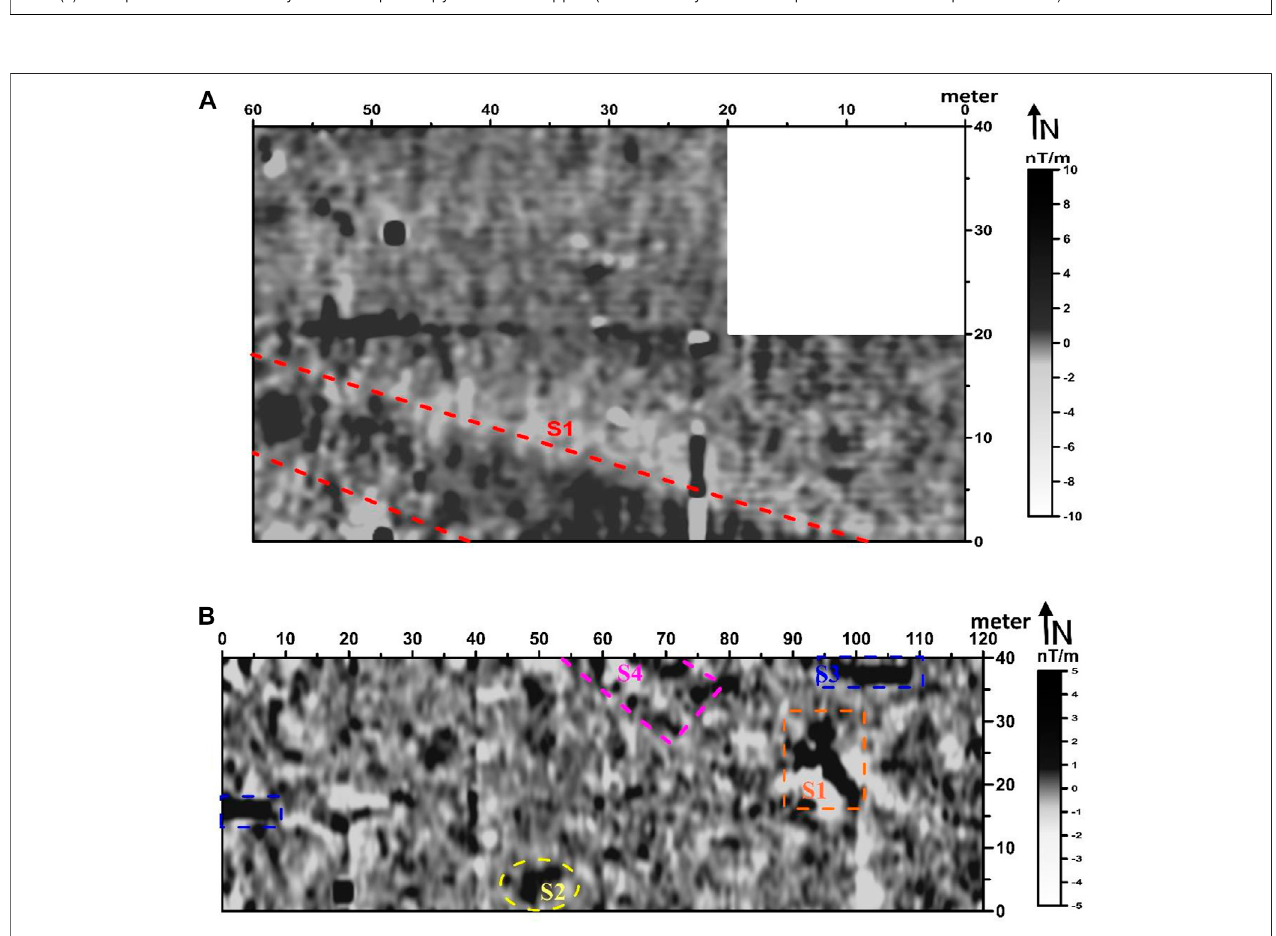
FIGURE 3 | (A) Gradiometer data of site B, after applying the processing functions. This plot shows the anomaly zone S1. (B) Gradiometer data of site C, after applying the processing functions. This plot shows the interested magnetic anomaly zones. S1, S2, S3, and S4 delineate the main discoveries in this area.